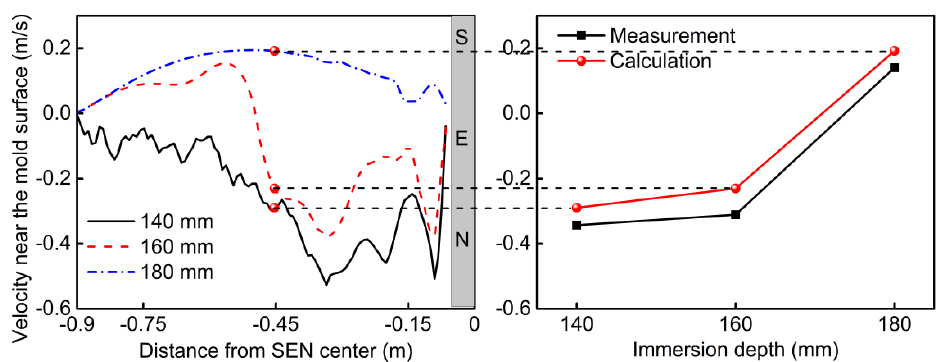
Figure 9. Comparison of measured and calculated surface velocities of mold at different immersion depths.